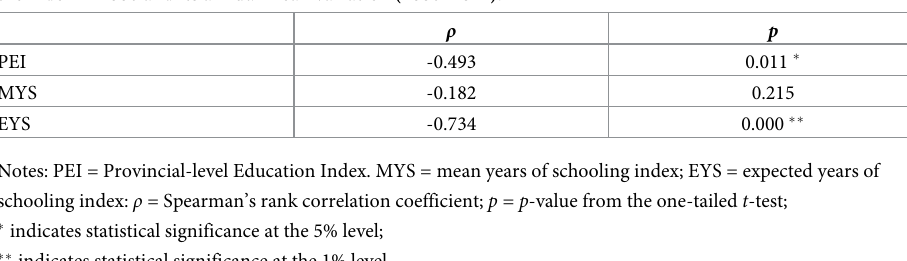
Table 2. Provincial-level Education Index and its components: Spearman´s rank correlation coefficient between the index in 2006 and its annual mean variation (2006–2014).